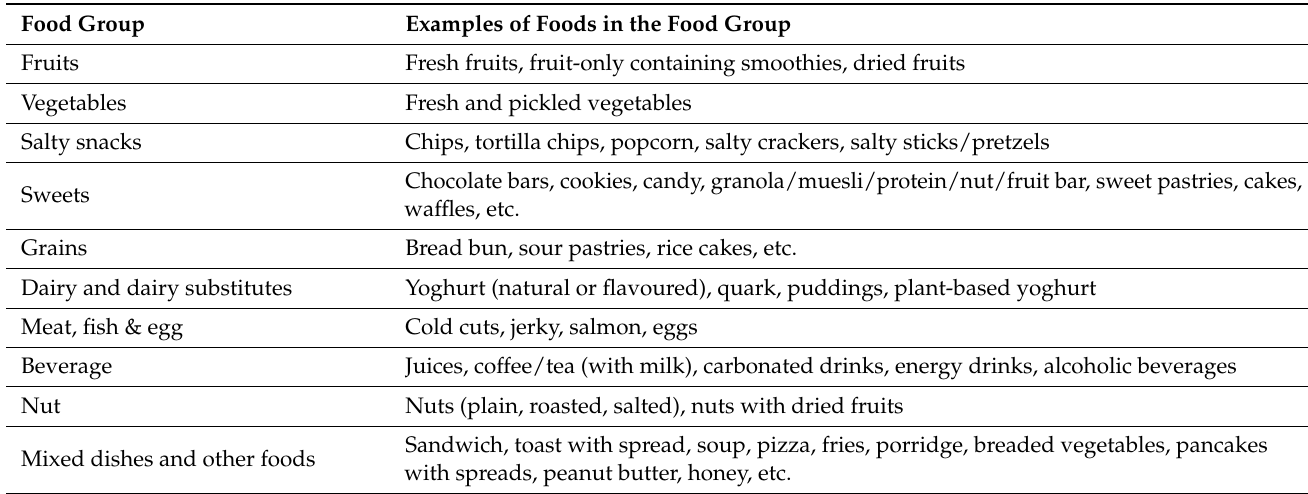
Table 1. Food groups with examples of foods corresponding to